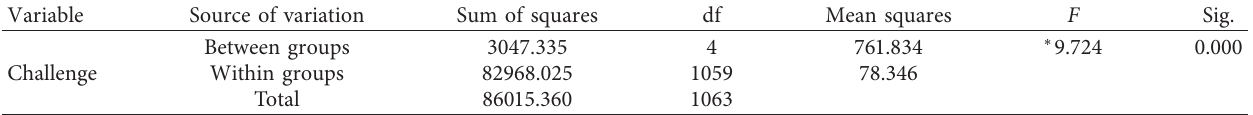
Table 6: Summary of ANOVA for issues related to challenges of cooperative learning by colleges.